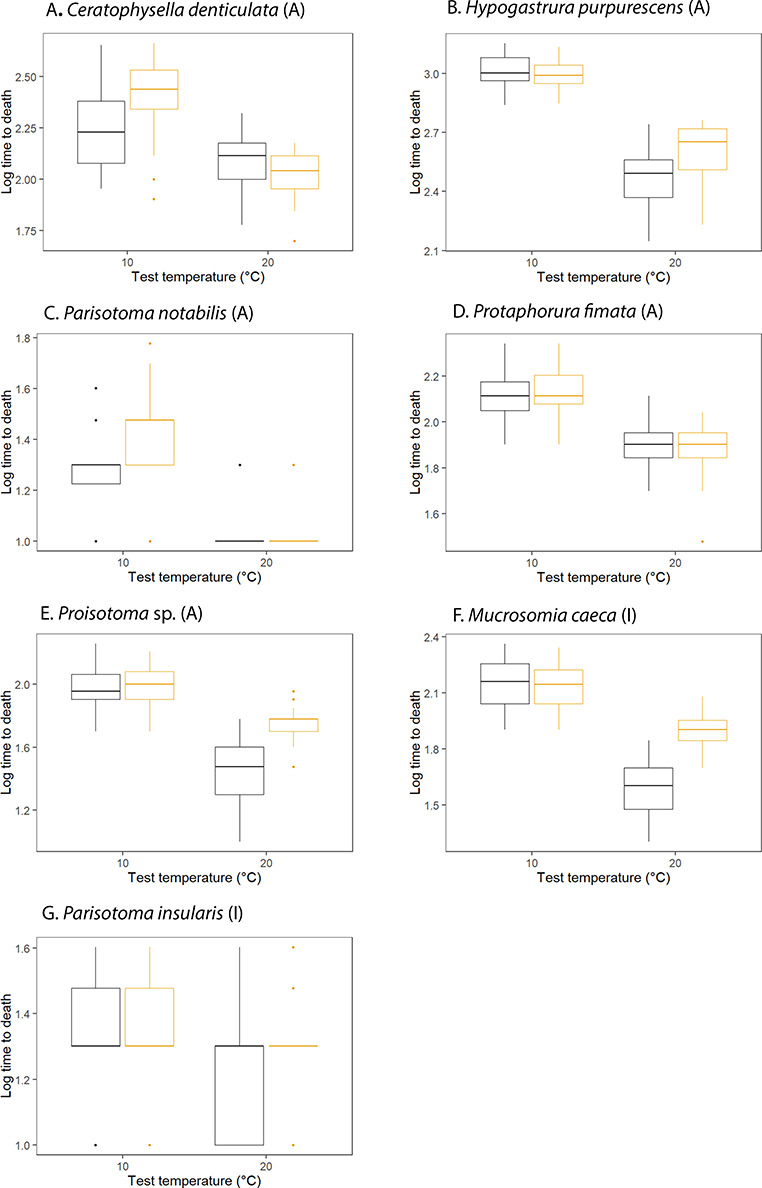
Boxplots illustrating the effects of different acclimation treatments [10°C (black) or 20°C (orange) for 1 week] on desiccation resistance (provided here as log10 time to death in minutes) measured under 76% relative humidity at a test temperature of either 10°C or 20°C. Summary data are available in Supplementary Table S9